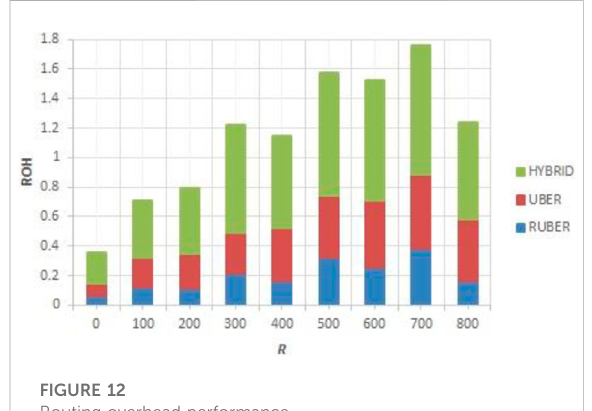
FIGURE 12 Routing overhead performance.